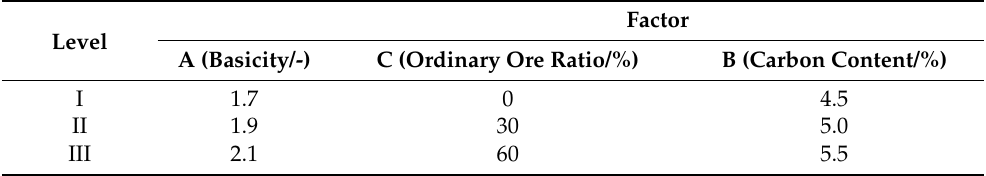
Table 3. Setting of sinter cup test factor and